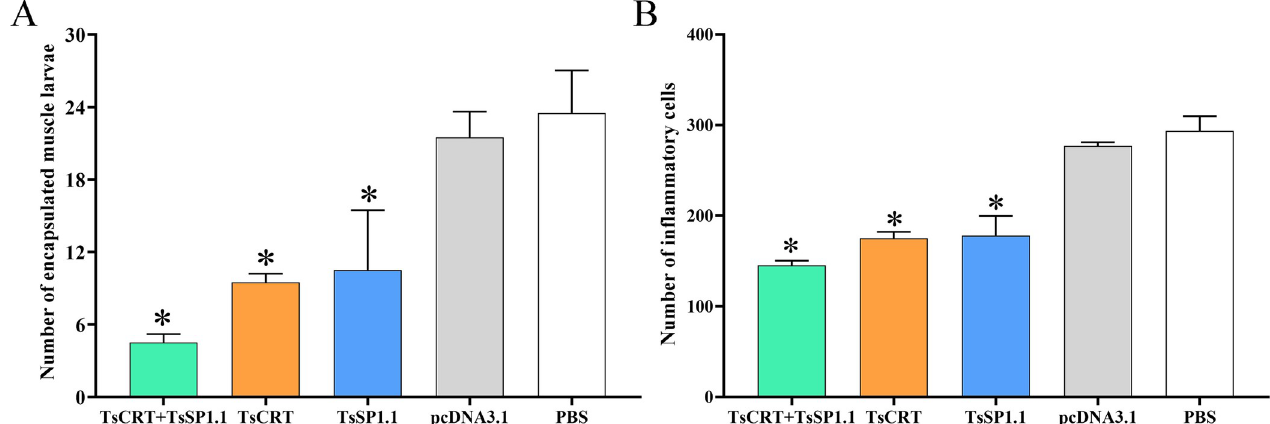
Fig 16. Muscle pathological changes in immunized mice at 35 days after T . spiralis challenge. A: The encapsulated larvae are enumerated on the muscle sections per field (100 × ). B: The inflammatory cells (eosinophils, neutrophils and lymphocytes) are enumerated on the muscle sections per field (400 × ). � P < 0.0001 compared to the PBS